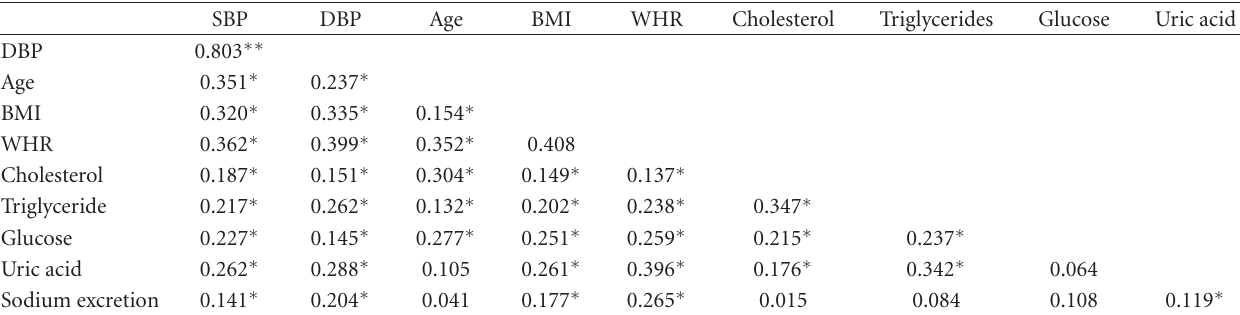
Table 3: Pearson’s correlation coe ffi cient between blood pressure levels, anthropometric and clinical variables in the total sample.